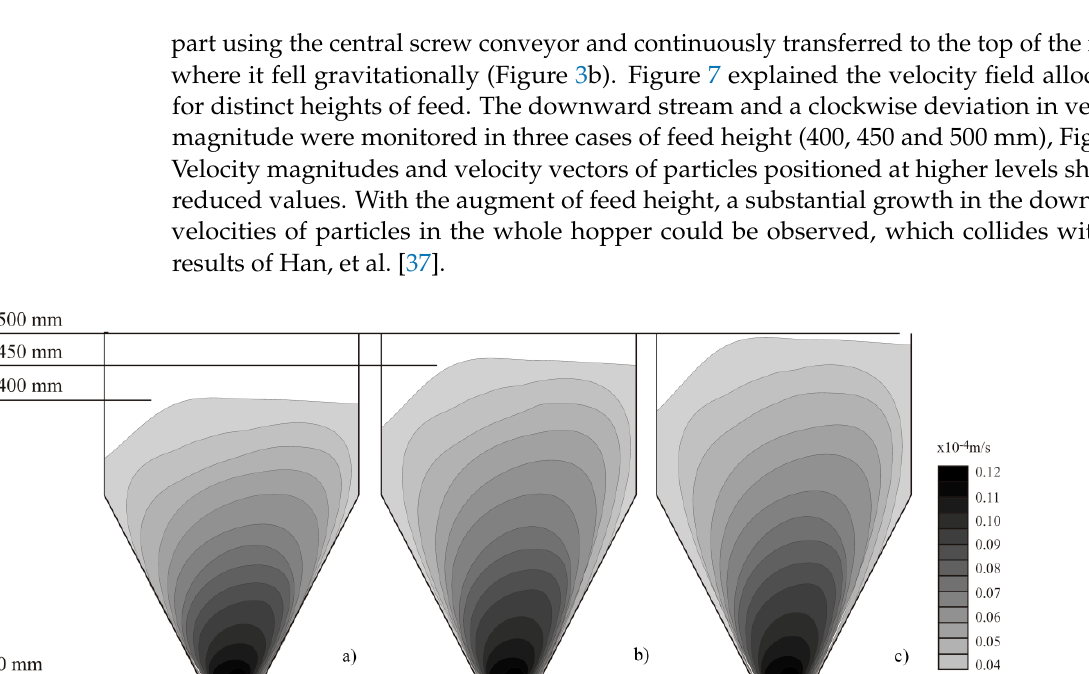
Figure 7. Distributions of the particle stream with distinct heights in the hopper of the conveyor mixer, in case of feed height: (a) 400 mm; (b) 450 mm and (c) 500 mm.